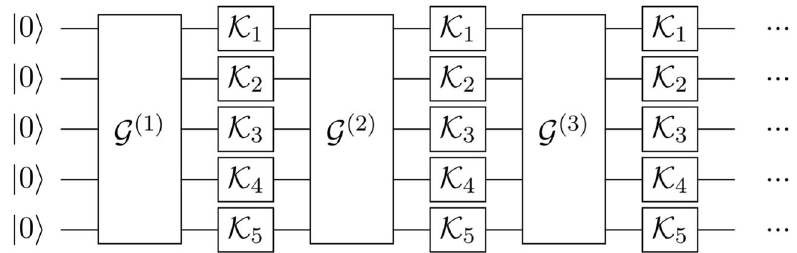
Fig. 2 Schematic of a noisy quantum circuit. G ð i Þ represents gate operations at the i th layer and K represents a one-qubit Kraus operator that models the